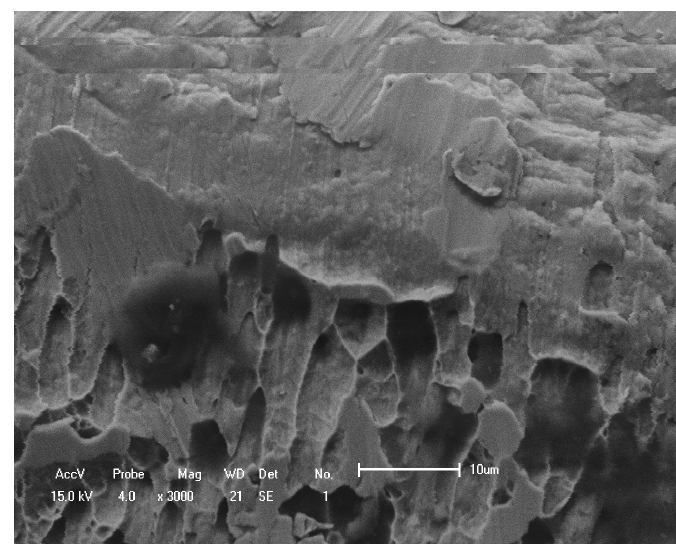
Figure 7. Fracture surface of the HAZ of 2304 DSS showing a mixed fracture mode. Note the presence of grain facets with fibrous appearance and islands of dimples.